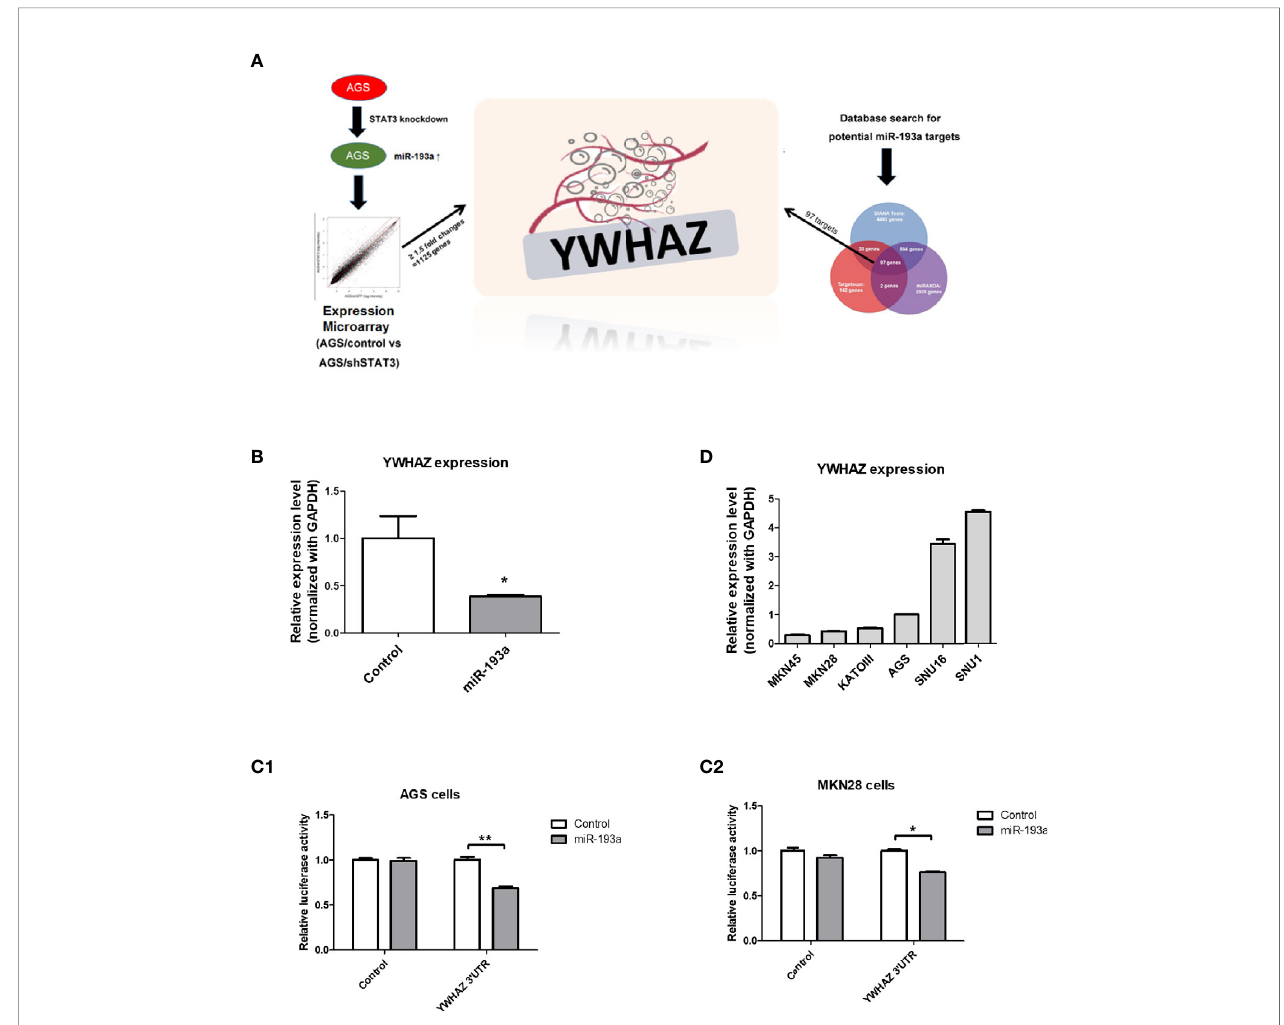
FIGURE 3 | Identi fi cation of YWHAZ as a novel miR193a target gene in gastric cancer. (A) Schematic diagram showing the experimental scheme of this study. AGS knockdown control (AGS/control) or STAT3 depleted cells (AGS/shSTAT3) were used to perform Illumina expression microarray. The scatter plot shows the fl uorescence signal of each gene on the array in AGS/control vs AGS/shSTAT3. There were 1,125 genes showing expression changes of ≥ 1.5-fold. In additional, bioinformatic analysis using three microRNA databases was performed to predict potential miR-193a targets. There are 97 potential miR-193a targets. YWHAZ, a potential miR-193a target showing downregulation in AGS/shSTAT3 cells (as compared to control) and has been shown to be involved in metastasis, was selected for further analysis. (B) Relative expression of YWHAZ in AGS gastric cancer cells overexpressed with control or miR-193a-expressing plasmid. 3 ’ UTR luciferase con fi rmed that miR-193a targets YWHAZ in (C1) AGS and (C2) MKN28 cells. (D) Relative expression of YWHAZ in a panel of gastric cancer cell lines. Each bar represents mean ± SD of duplicate experiments (*P < 0.05, **p <